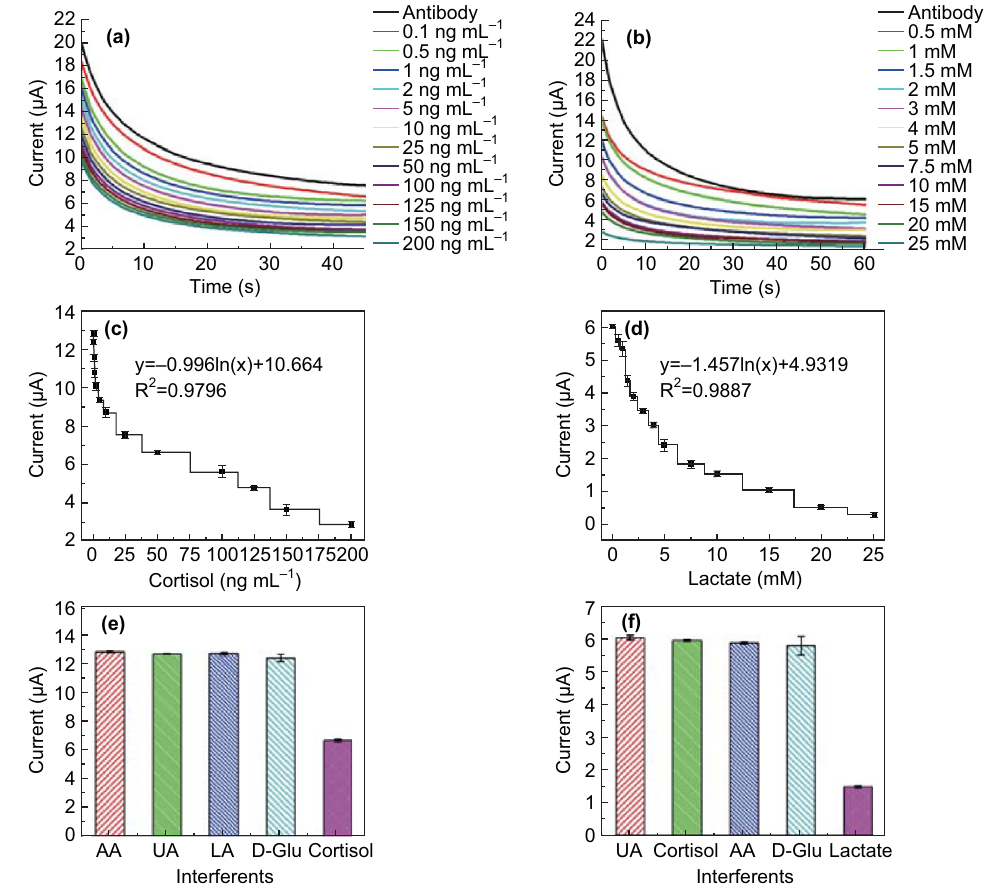
Fig. 6 Chronoamperometric curve recorded from Ab@e-RGO SPE vs. different concentrations of a antigen cortisol, b antigen lactate. c Calibration curve from anti-cortisol Ab@e-RGO SPE against various concentrations of antigen cortisol. d Calibration curve from anti-lactate Ab@e-RGO SPE against various concentrations of antigen lactate. e, f Investigations of sensor response toward cortisol and lactate, respectively, in addition to other non-specific proteins, to assess the device’s specificity (concentration was fixed at 1